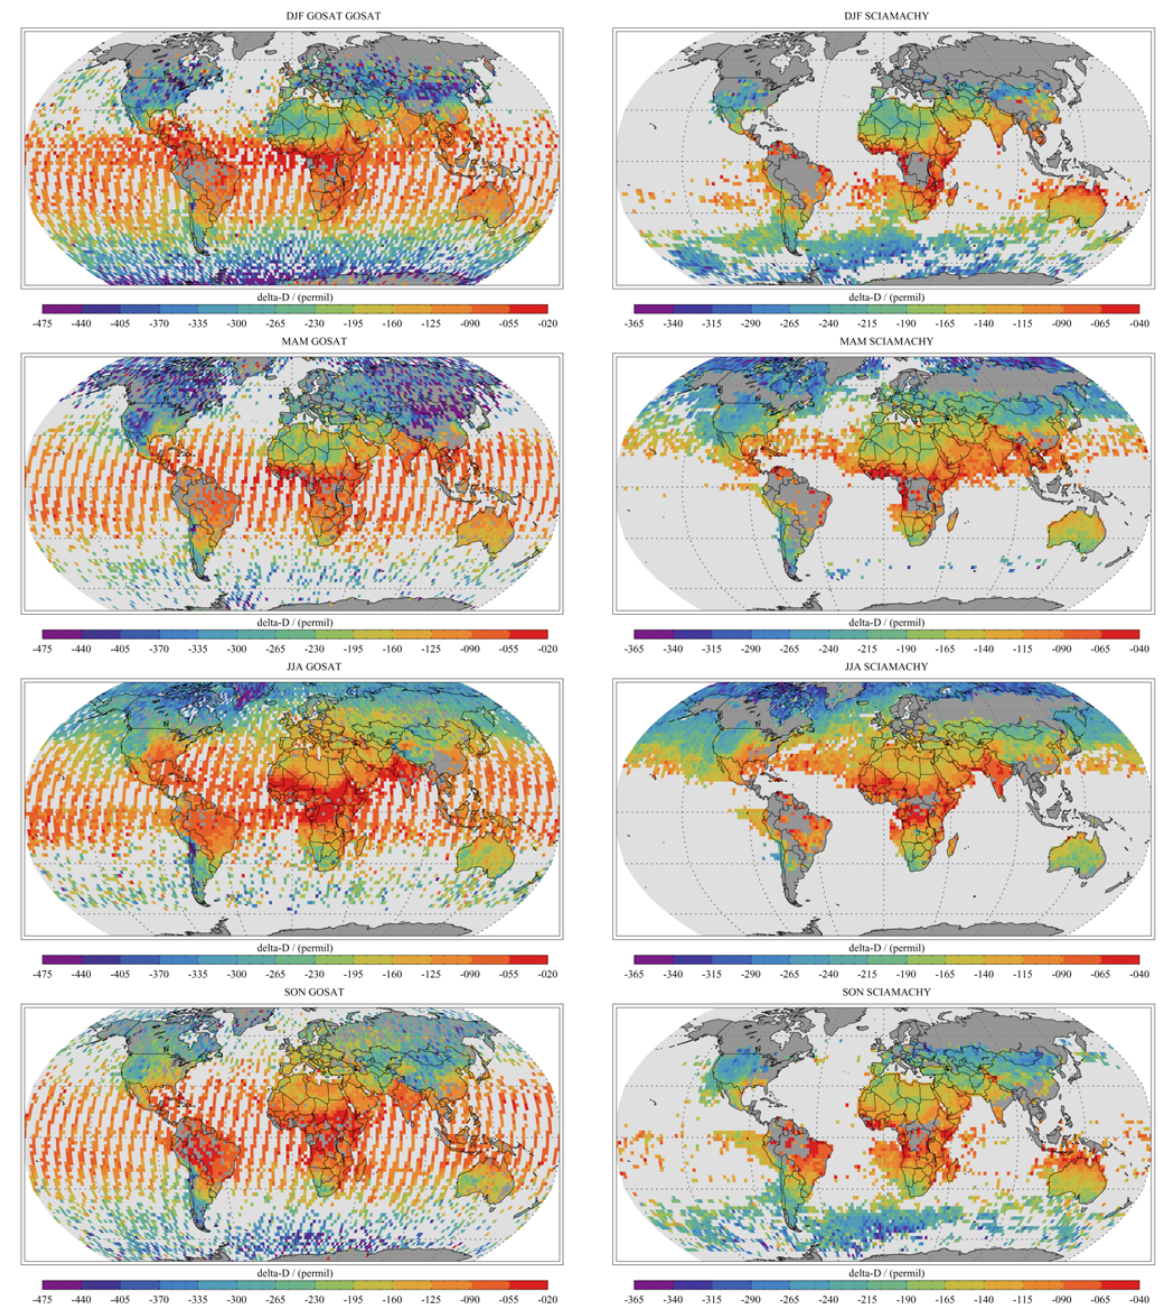
Fig. 10. Spatial distribution of seasonal 2 × 2 degree grid box averages of δ D 0 for GOSAT (left panels, 2009–2011) and SCIAMACHY (right panels,